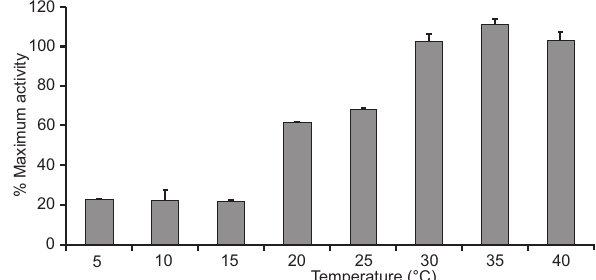
Figure 3. Temperature-dependent hemolysis of SRBCs by plasma of the freshwater turtle P. geoffroanus . SRBCs were incubated with 100% turtle plasma at different temperatures for 60 minutes. The samples were centrifuged and the optical densities of the supernatants were measured at 540 nm. Each sample was analyzed in quadruplicate and the results represent the mean ± standard